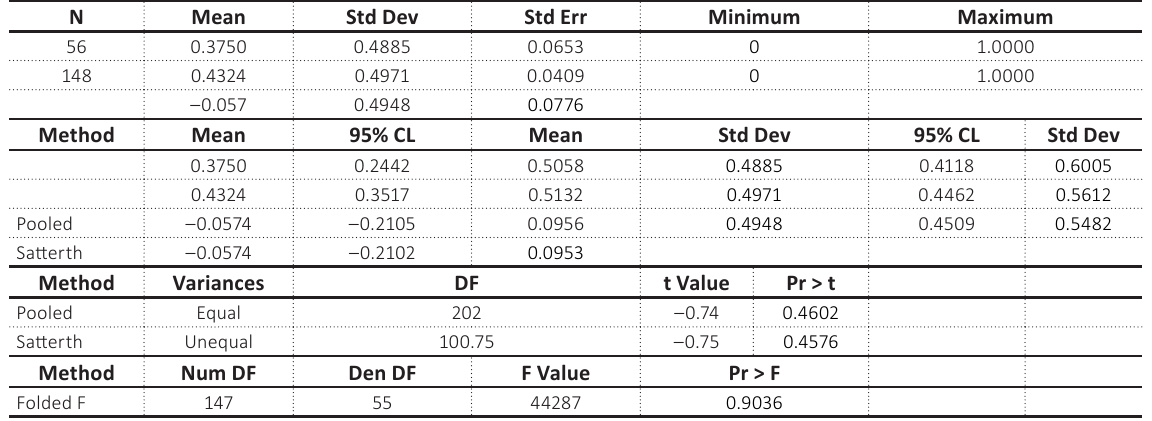
Table 2. Job satisfaction